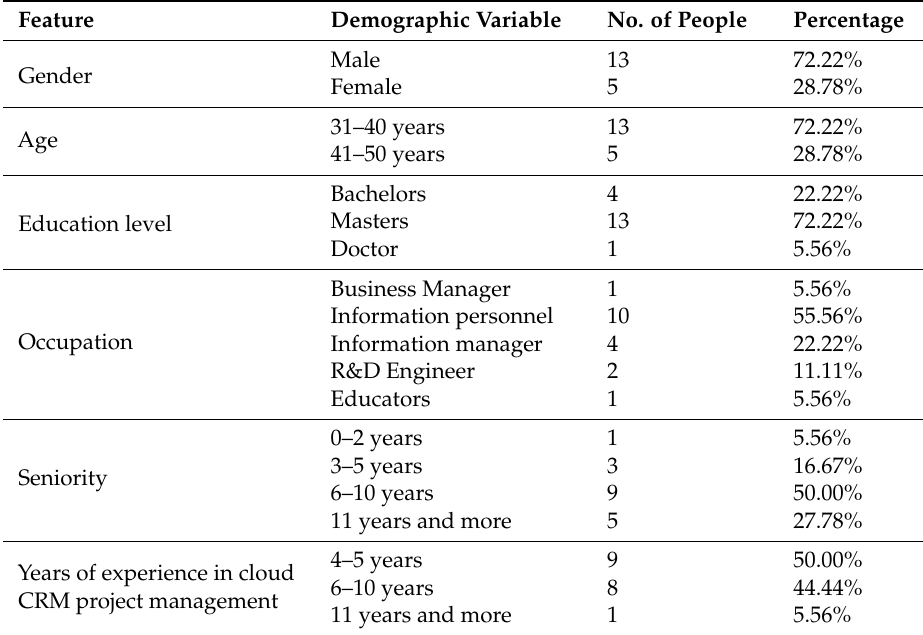
Table 5. Demographic data of the cloud customer relationship management